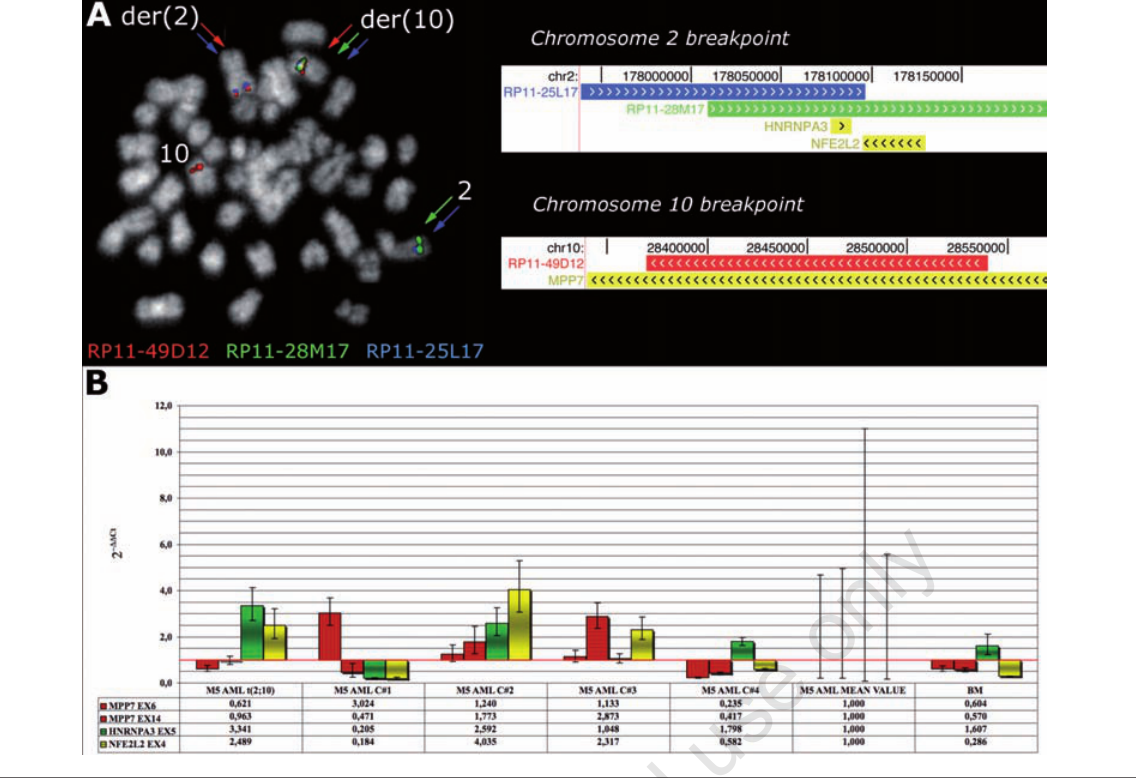
Figure 1. A) Left: Fluorescence in situ hybridization (FISH) results obtained with bacterial artificial chromosome clones delimiting the breakpoint regions on der(2) and der(10). Right: Maps of the breakpoint regions in chromosome bands 2q31.2 (top) and 10p11.23 (bot- tom), according to the latest release of the UCSC Human Genome Browser (GRCh37/hg19) (February 2009). Genes are indicated by yellow bars. The reported clones have the same color code as the FISH image on the left. B) Expression analyses of exons 6 and 14 of MPP7 (red bars), exon 5 of HNRNPA3 (green bar), and exon 4 of NFEL2L2 (yellow bar) evaluated by real-time quantitative polymerase chain reaction, in the present case [t(2;10)], 4 control akute myeloid leukemia (AML) M5 samples, the mean Ct value of the controls (mean value), and normal bone marrow. The results showed comparable genes transcriptional levels in the patient with t(2;10) compared with the mean Ct value of the 4 M5 AML